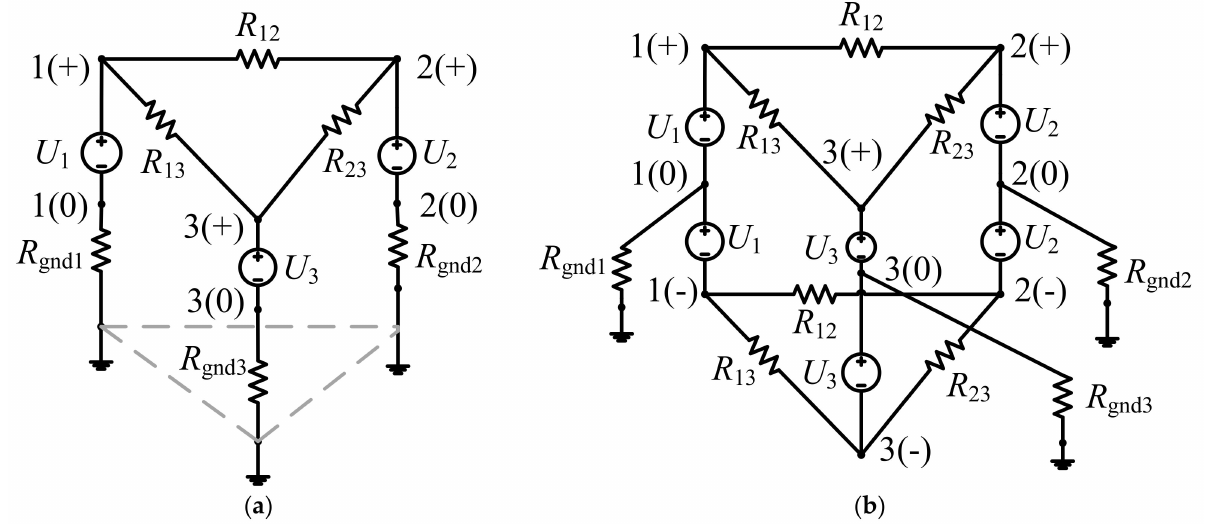
Figure 3. Ground return schemes in MTDC network ( a ) monopole and ( b ) bipolar